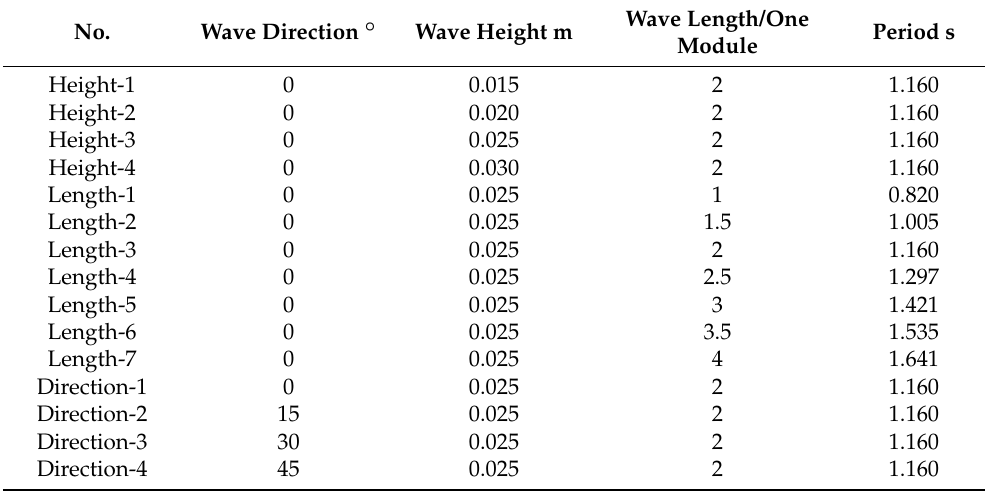
Table 2. Experiment conditions.